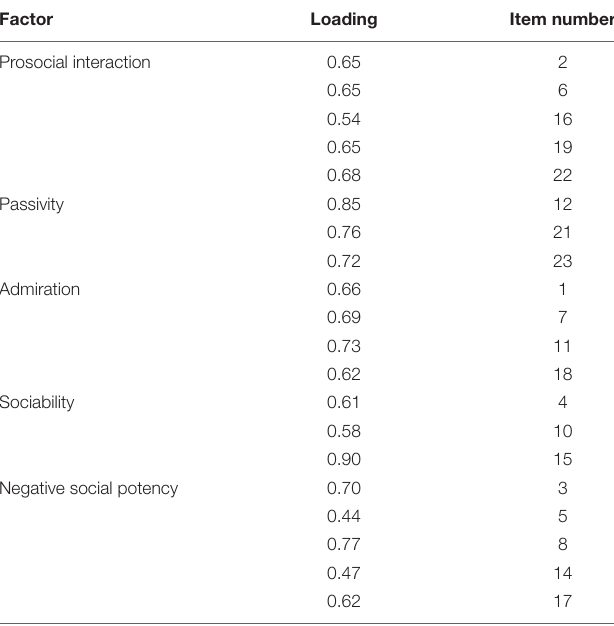
TABLE 1 | Standardized factor loadings from the five-factor CFA.